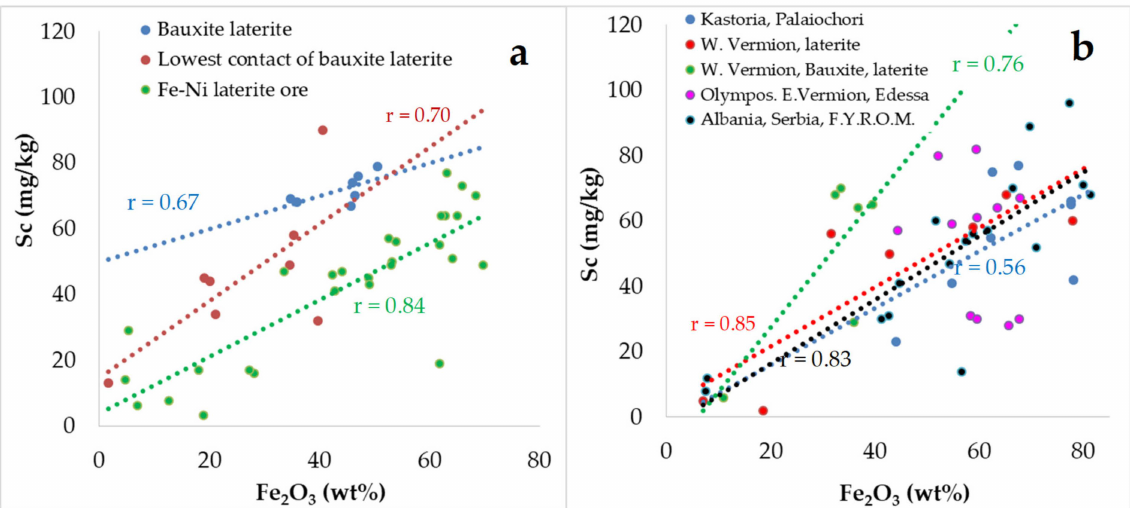
Figure 9. Plots of Sc versus Fe 2 O 3 for Fe–Ni laterites and bauxite laterites from the Balkan Peninsula. The best posi- tive correlation between Sc and Fe is observed in the Fe–Ni laterite deposits of Lokris ( a ) and W. Vermion ( b ). Data from Tables